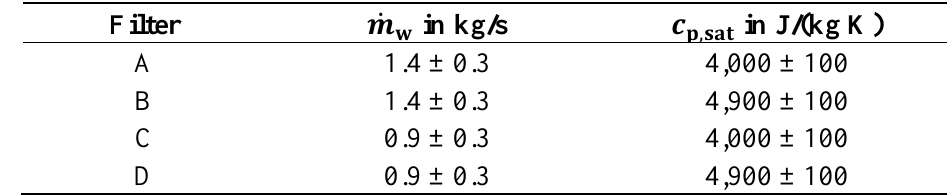
Table 3. Description of filtered data for simulated wet cooling tower Type 51 in TRNSYS